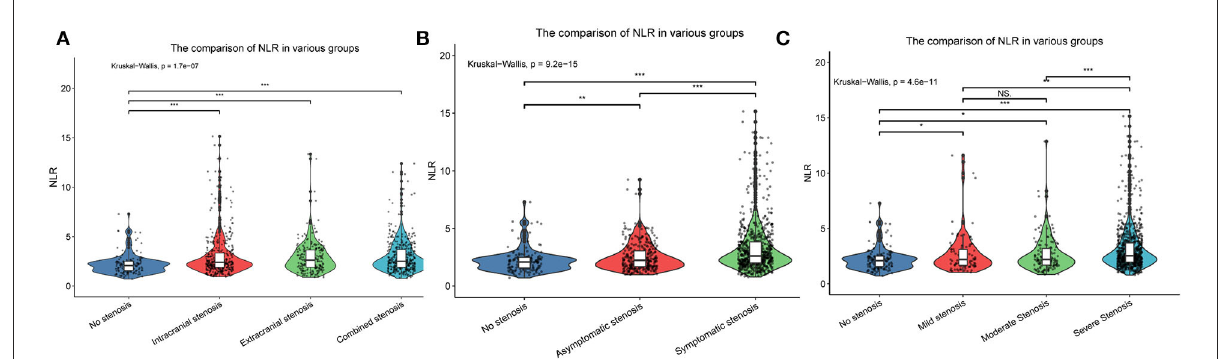
FIGURE2 The violin plots demonstrating the distribution of the NLR levels among patients in different groups: (A) Without stenosis, intracranial stenosis, extracranial stenosis, and combined intracranial and extracranial stenosis; (B) Asymptomatic stenosis and symptomatic stenosis; (C) Mild stenosis, moderate stenosis, and severe stenosis. NLR, neutrophil-to-lymphocyte ratio. *p < 0.05, **p < 0.01, ***p < 0.001. NS: not significant.